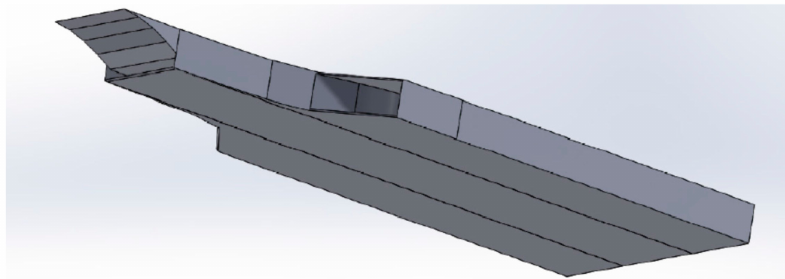
Figure 26. Rotated ramjet configuration.